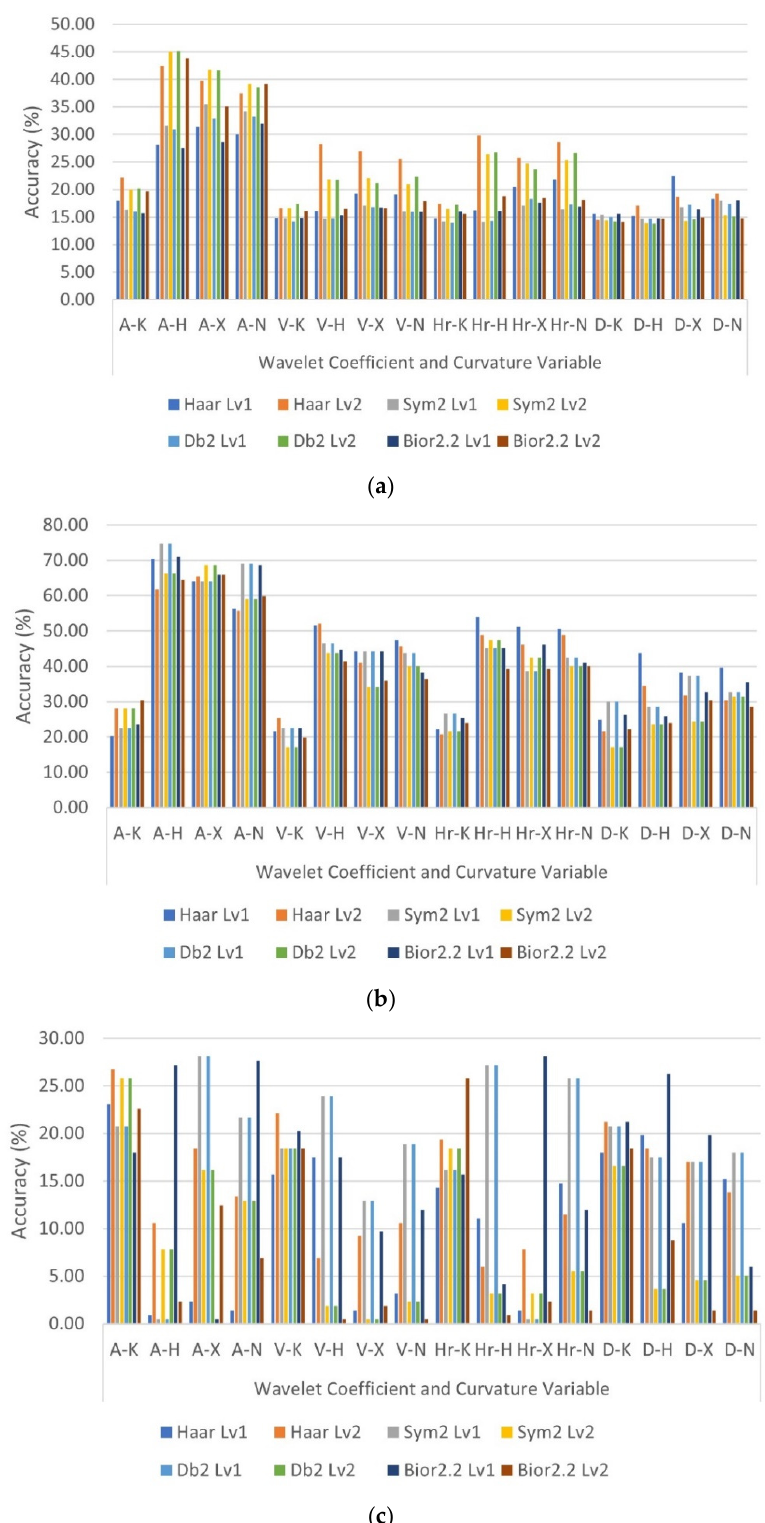
Figure 5. The accuracy results (%) from ( a ) 1- NN , ( b ) SVM -1 , and ( c ) SVM -2. The results were evaluated for a total of 16 variables for wavelet coefficients ( A , V , Hr , and D ) with 2 decomposition levels and curvature-based methods ( K , H , X , and N ).